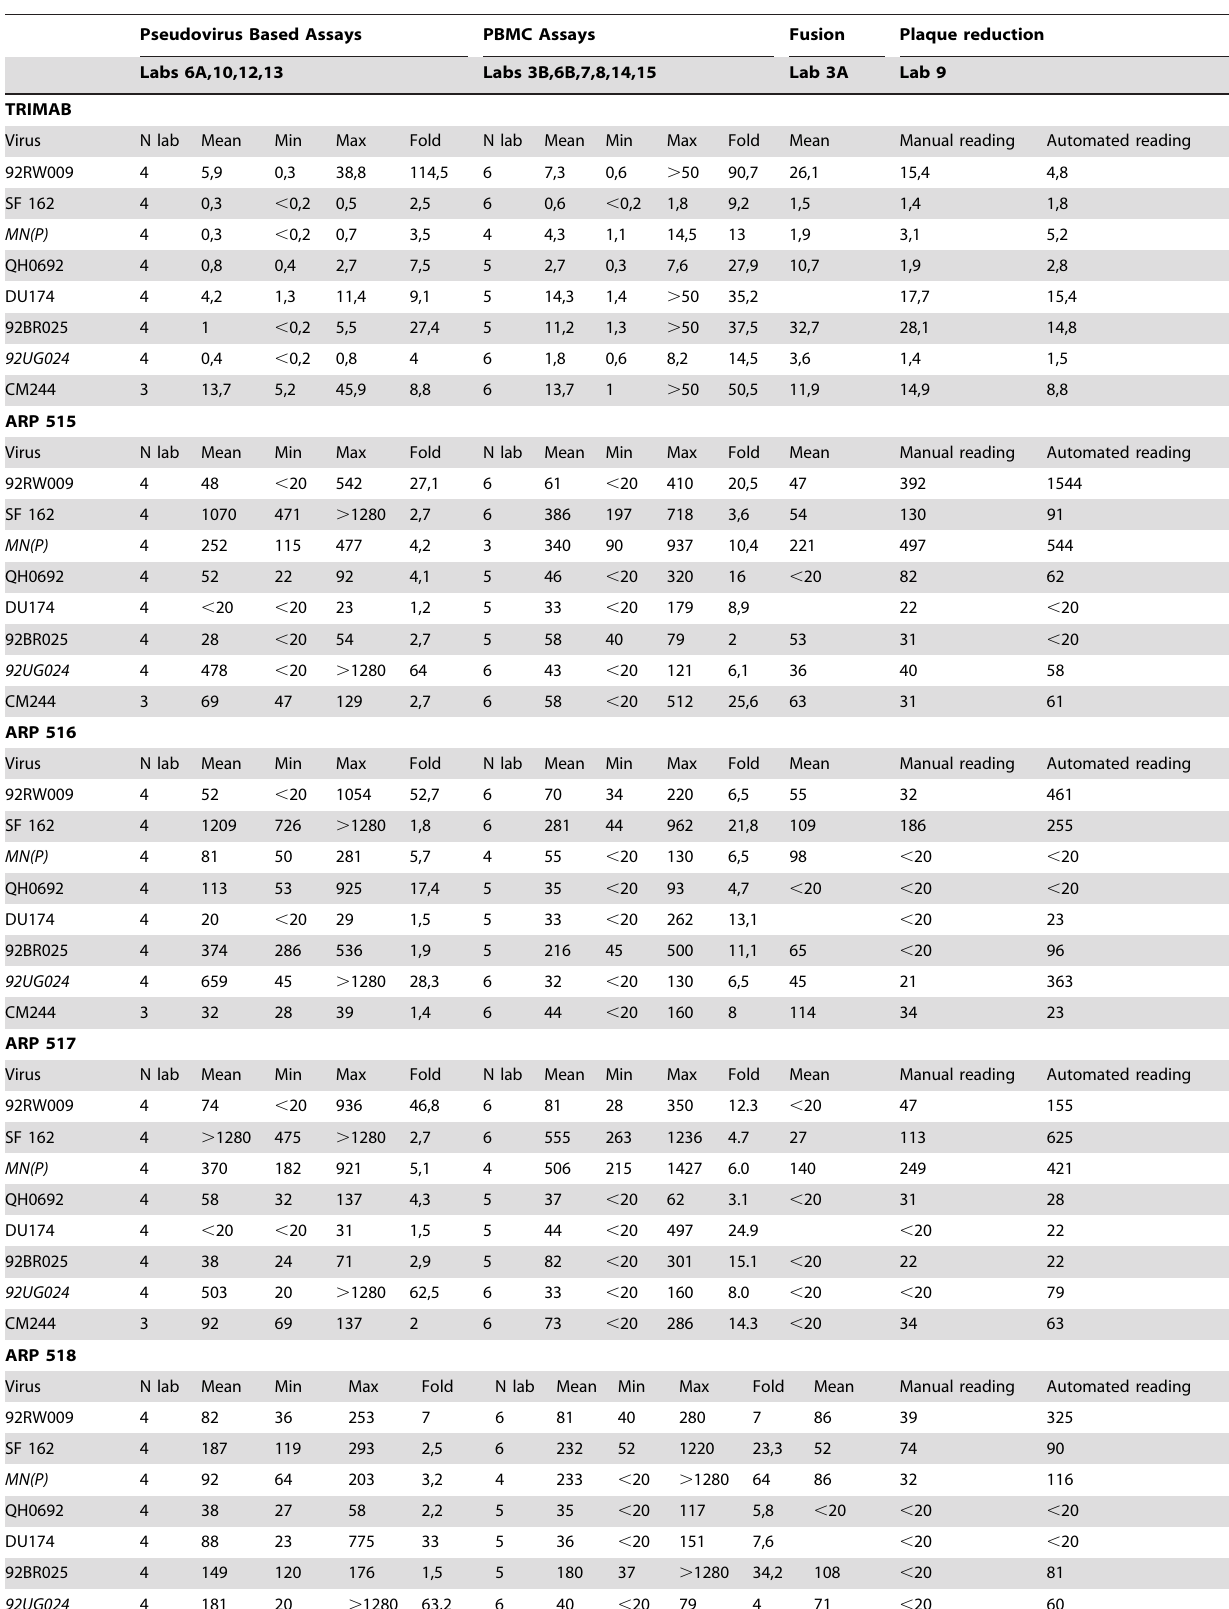
Table 2. Inter-Laboratory comparisons IC50